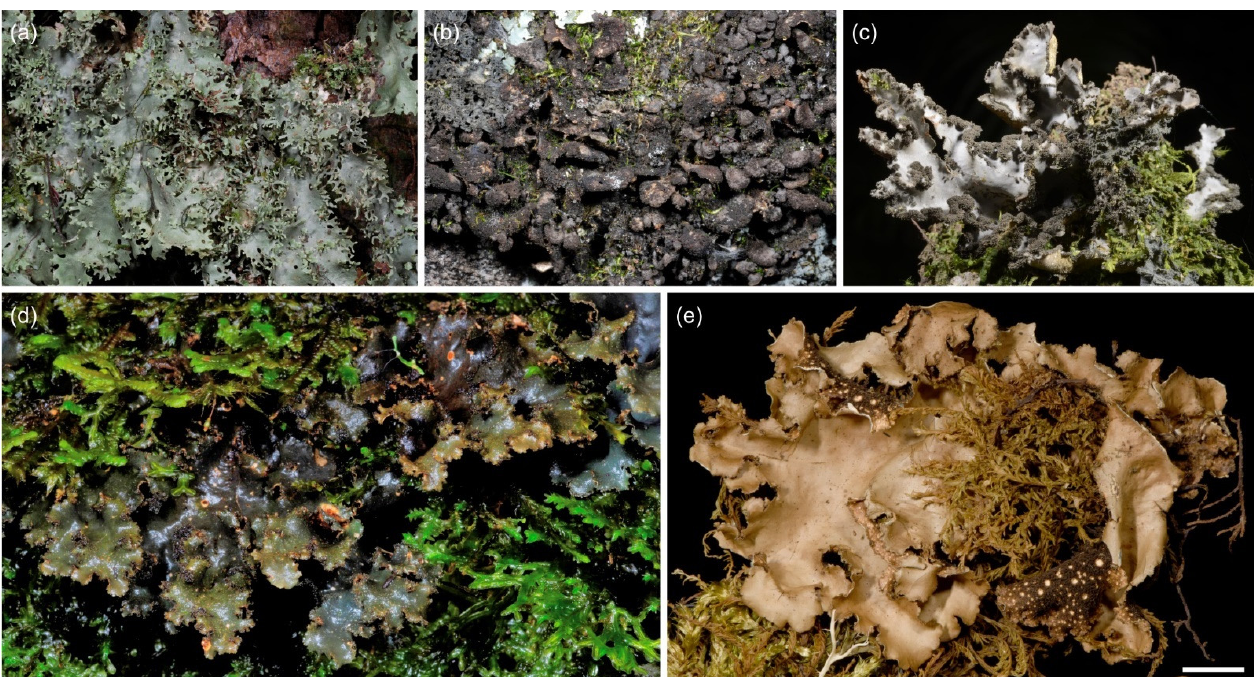
Figure 6. Sticta sp. 2, Sticta sp. B ( ciliata agg.), Sticta sp. C ( weigelii agg.), and Sticta andina . ( a ) Sticta sp. 2, the only green algal species collected by us, photographed in situ on Mt. Kasigau and showing the characteristic abundant and delicate marginal phyllidia (JR10K302). ( b ) Sticta sp. B, closely resembling S. ciliata , photographed in situ on Shomoto Hill and displaying the small, dark brown, rounded lobes and laminal isidia (JR10060). ( c ) Sticta sp. C photographed in situ in Sagalla forest with the characteristic congested heaps of cylindrical-coralloid isidia in the margins of the elongate lobes (JR16295). ( d , e ) Sticta andina (JR10117). ( d ) Photographed in situ on Vuria Mountain. ( e ) When dry, the species has a yellowish–brown upper surface and dark brown lower surface. Scale 0.5 cm in ( e ).